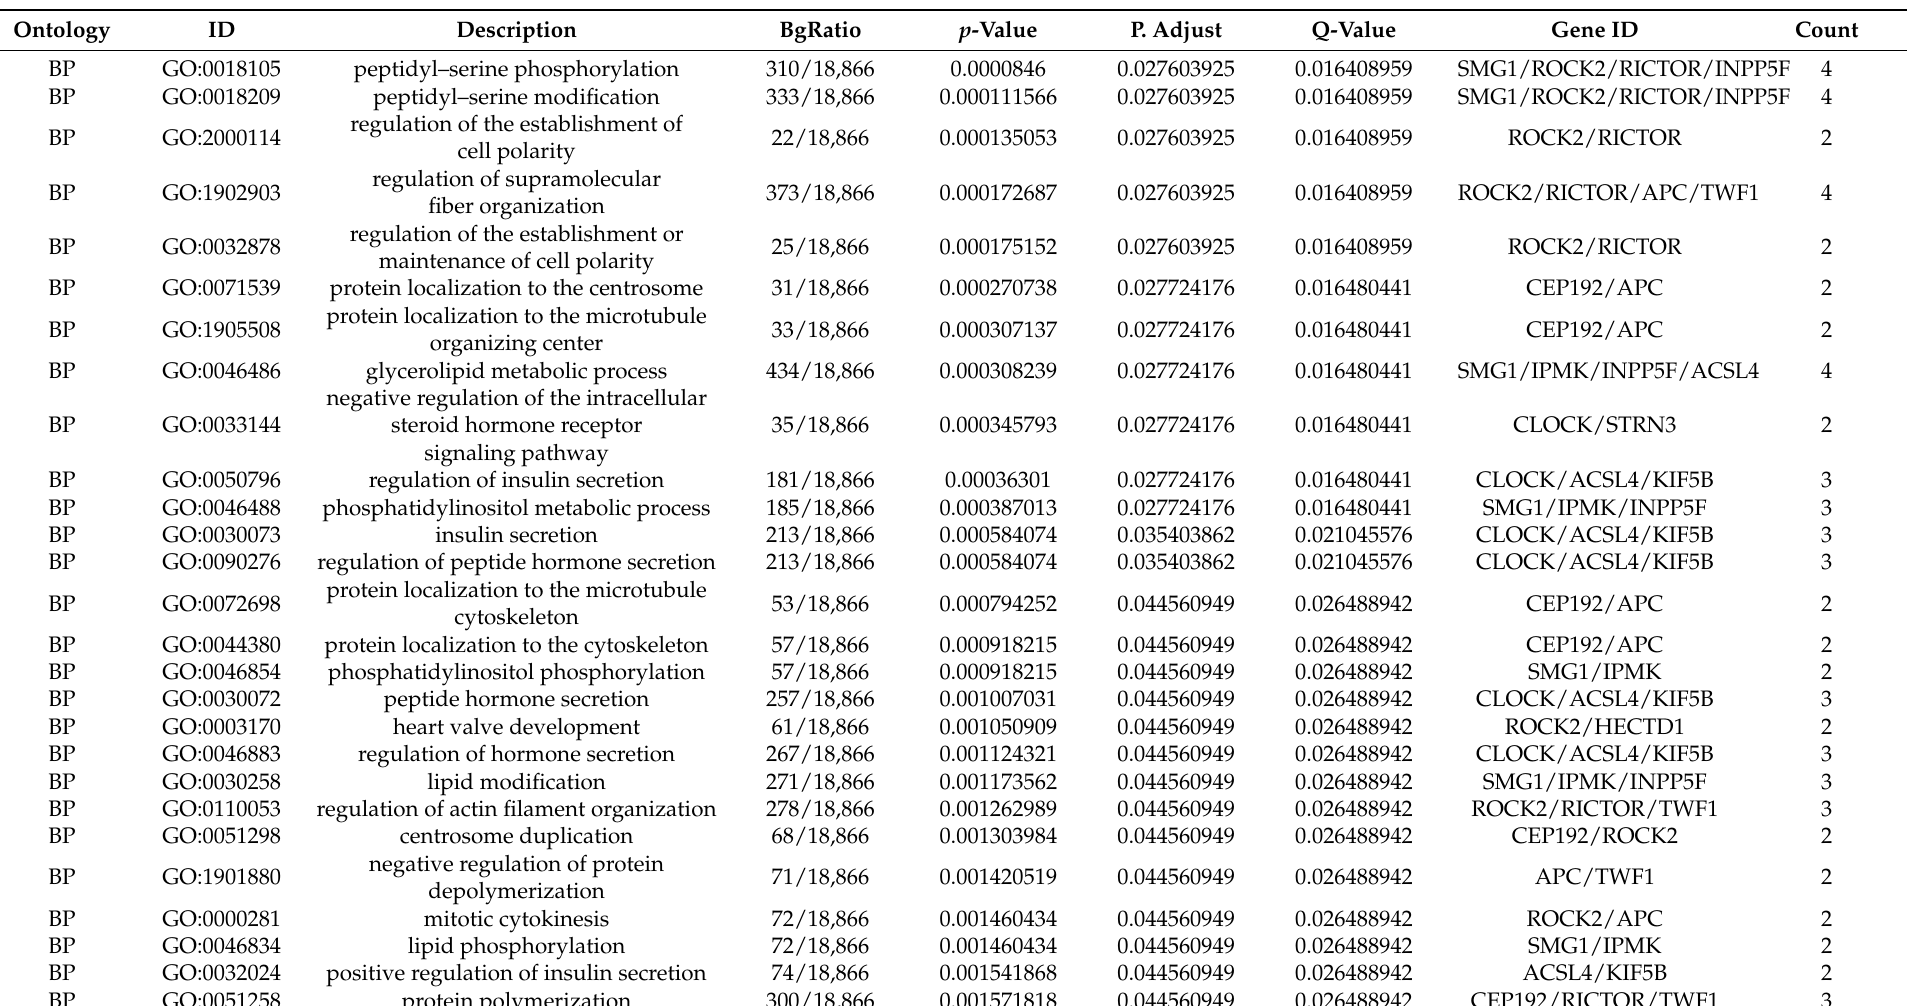
Table 1. GO enrichment analysis of the ceRNA